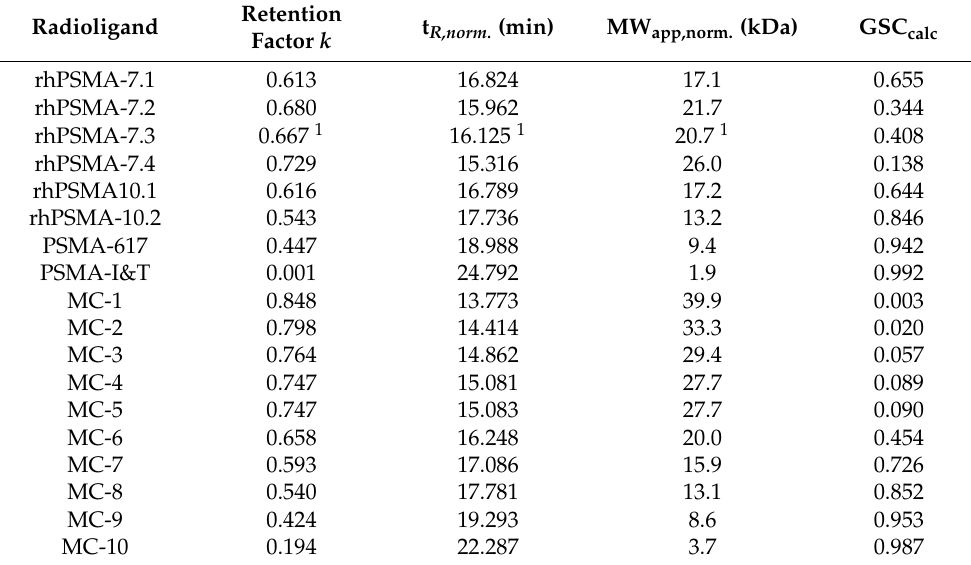
Table 2. Retention factors k , normalized retention times (t R,norm. ), normalized apparent molecular weights (MW app,norm. ), and calculated glomerular sieving coefficients (GSC calc ) of rhPSMA radioli- gands, PSMA-617, PSMA-I&T, and model compounds (MCs) 1 to 10. Retention t R,norm. (min) MW app,norm. (kDa) GSC calc Radioligand Factor k rhPSMA-7.1 0.613 16.824 17.1 0.655 rhPSMA-7.2 0.680